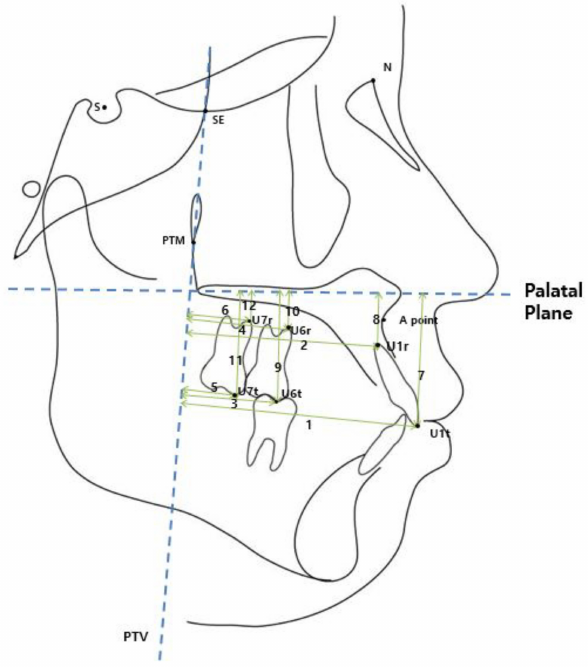
Figure 3. Cephalometric dental linear measurements of maxilla. Horizontal measurements: 1, PTV to incisor tip; 2, PTV to incisor root; 3, PTV to first molar cusp; 4, PTV to first molar root; 5, PTV to second molar cusp; 6, PTV to second molar root. Vertical measurements: 7, PP (palatal plane) to incisor tip; 8, PP to incisor root; 9, PP to first molar cusp; 10, PP to first molar root; 11, PP to second molar cusp; 12, PP to second molar root.